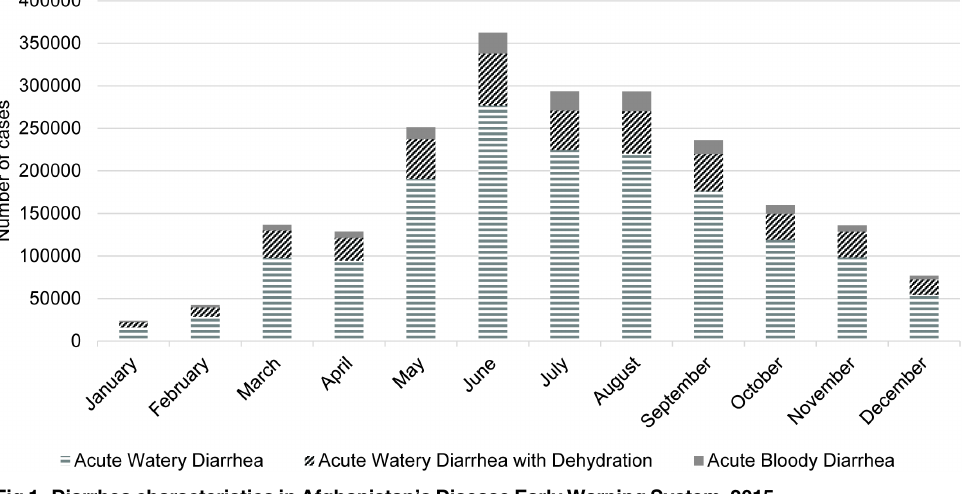
Fig 1. Diarrheacharacteristics in Afghanistan’s DiseaseEarly Warning System, 2015.